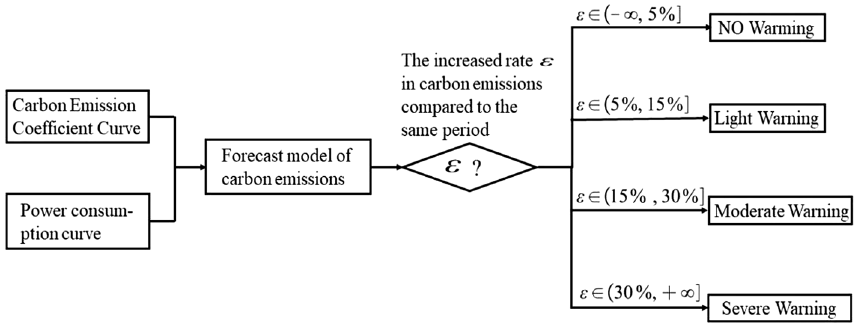
Figure 8. Community carbon emission warning